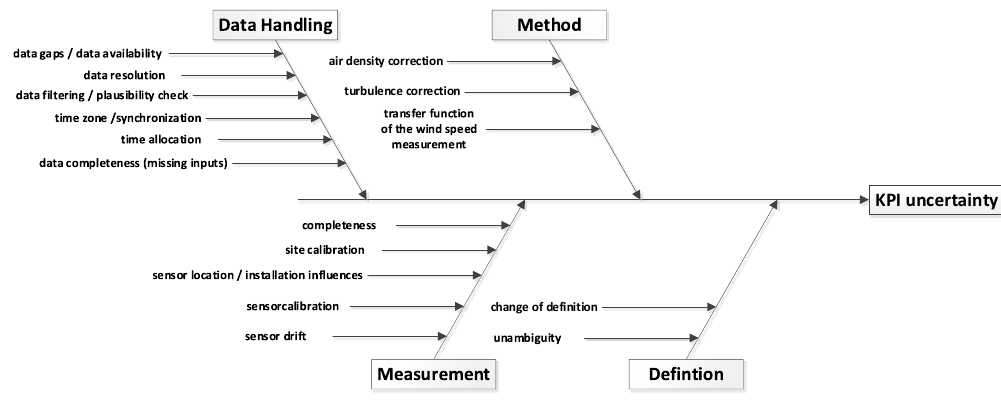
Figure 1. Exemplary causes for uncertainties of performance KPIs grouped by their categories in a causal